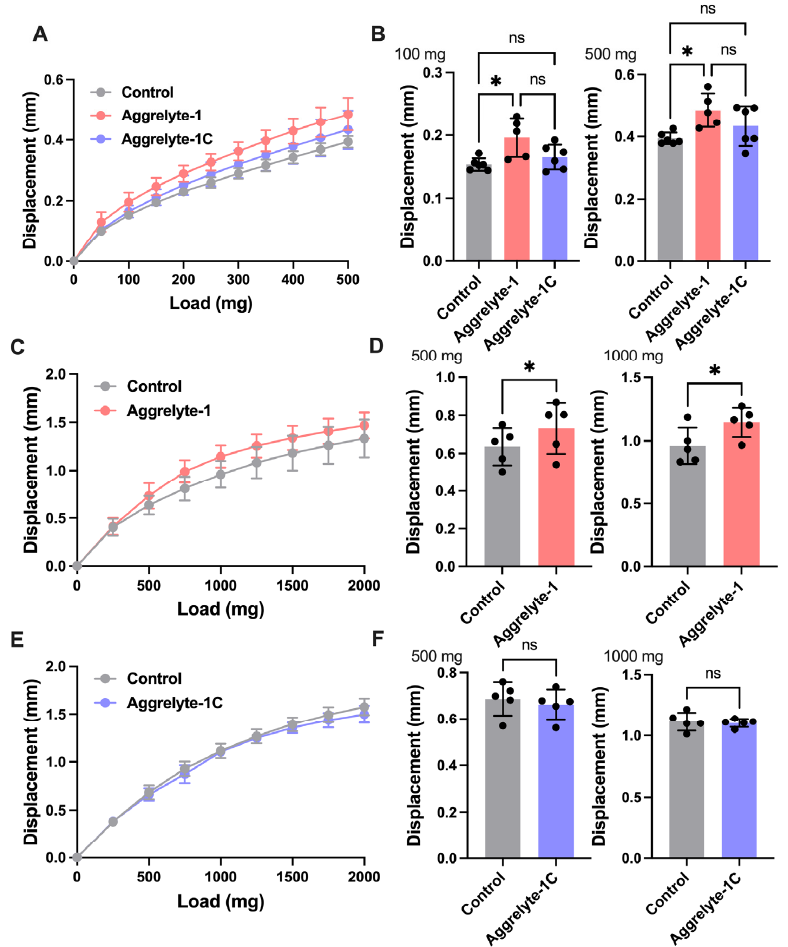
Figure 5. Aggrelyte-1 decreased the stiffness of mouse and human lenses. Mouse lenses (from 7-month-old C57BL6/J mice) and human lenses (44–66 years) cultured ex vivo were treated with 2000 µM aggrelyte-1 or aggrelyte-1C for 24 h and 72 h, respectively, in serum-free MEM as described in the Methods section. Lens stiffness was measured using a computer-controlled lens squeezer ( A , C , E ). The lens displacement was measured at various loads. The bar graphs on the right show displacement at 100 mg and 500 mg load for mouse lenses ( B ) and 500 mg and 1000 mg load for human lenses ( D , F ). The bar graphs represent the mean ± S.D. of 5–6 measurements. * p < 0.05, ns = not significant.